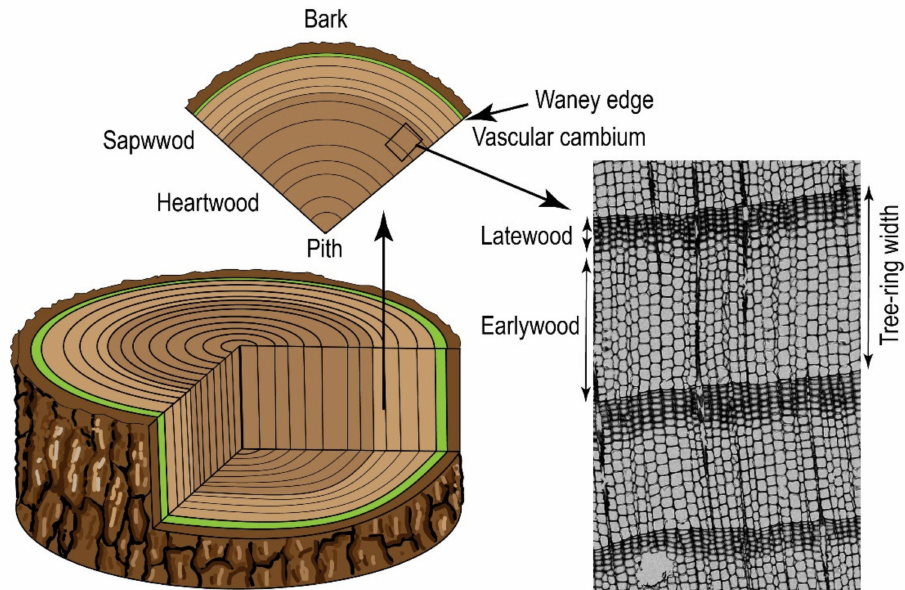
Figure 3. Schematic cross section of a tree with pith in the centre, thereafter heartwood, sapwood, waney edge, vascular cambium, and bark. The oldest rings are located closest to the pith, whereas the most recently formed ring is located just beneath the waney edge and the bark. To the right, annual rings from a pine tree showing earlywood, latewood, and total tree-ring width.